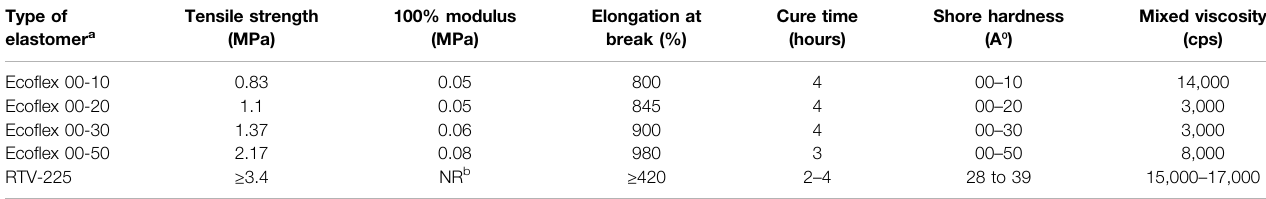
TABLE 2 | Properties of silicone elastomers (Khan et al. 2019).